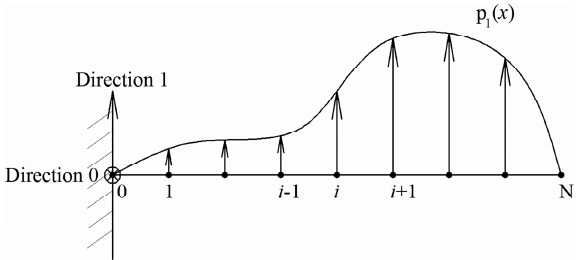
Figure 3. The diagrammatic sketch of the forces on the cantilever beam.